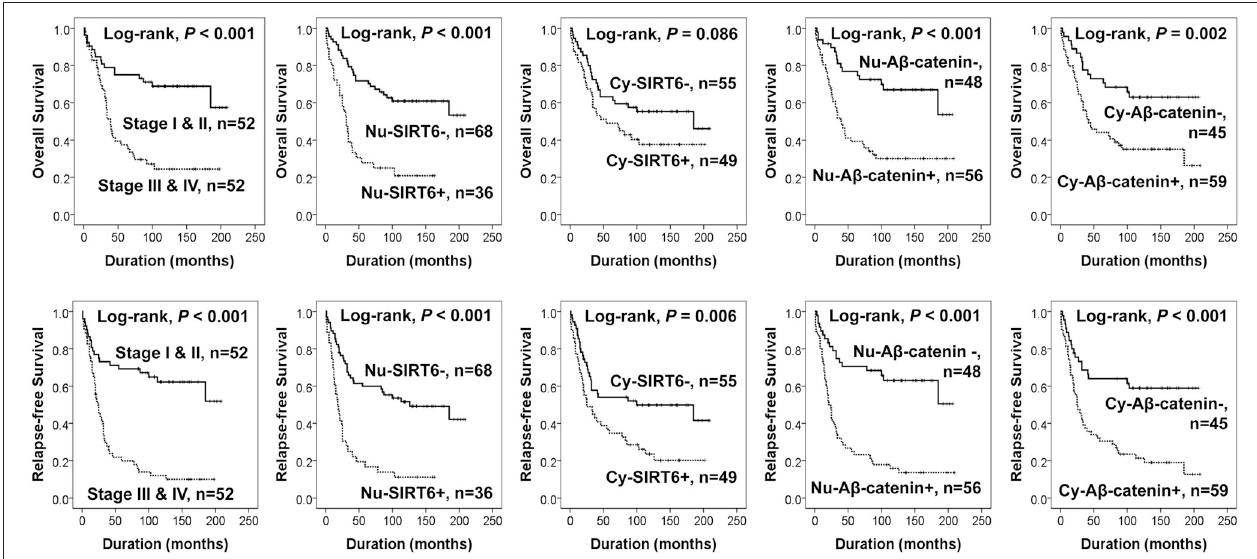
FIGURE 2 | Kaplan-Meier survival analysis in 104 ovarian carcinomas. Overall survival and relapse-free survival according to tumor stage and immunohistochemical expression of SIRT6 and active β -catenin in tumor cells. Nu-SIRT6, nuclear expression of SIRT6; Cy-SIRT6, cytoplasmic expression of SIRT6; Nu-A β -catenin, nuclear expression of active β -catenin; Cy-A β -catenin, cytoplasmic expression of active β